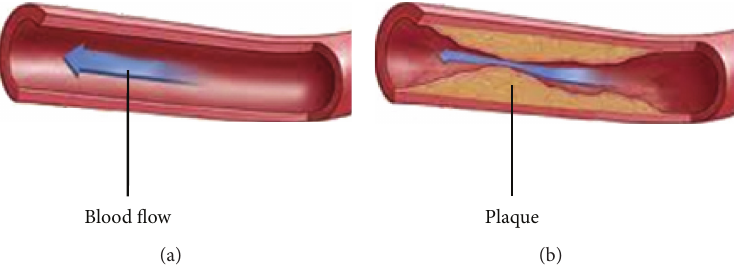
Figure 10: Artery blood flow. (a) Normal artery; (b) Artery with atherosclerosis.